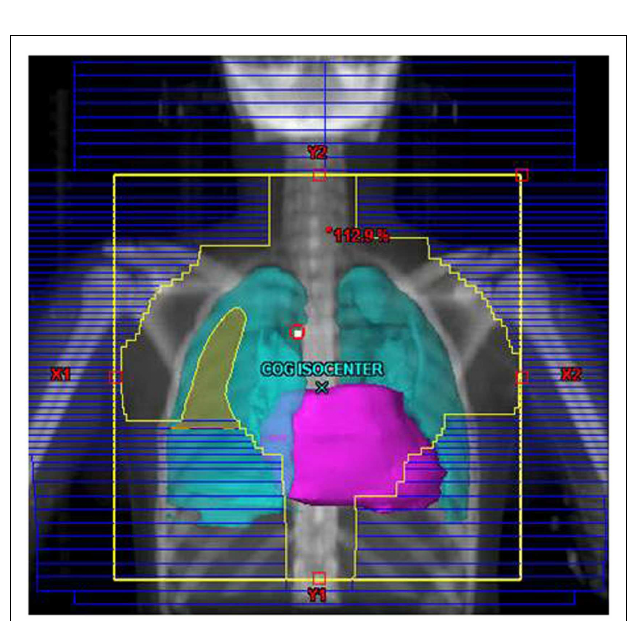
FIGURE 2 |Treatment field definitions for ECOG 2496Arm B, planned on COG protocol image set .